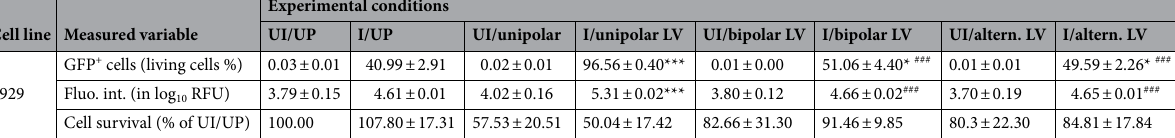
Table 2. Comparison of GFP gene expression and survival of L929 cells after adenovirus infection and delivery of various LV pulse types. L929 cells were infected (MOI = 10 4 vp/cell) and subjected to ten LV pulses either unipolar, bipolar, or with alternate polarities, respectively. GFP + cells (in % of living cells), median of fluorescence intensity (in log 10 RFU) and cell survival (in % of UI/UP cells) were scored by flow cytometry analysis 24 h ± 30 min after the treatment. UI uninfected, I infected, UP unpulsed, LV application of low voltage pulses, fluo. int. fluorescence intensity, altern. alternate. Data are presented as means ± SD (n = 3). Statistical significances: * p < 0.05 and *** p < 0.001 stand for comparisons of GFP + cells and fluorescence intensity versus I/UP condition; ### p < 0.001 for the same comparisons versus I/unipolar LV condition (one-way ANOVA with Bonferroni’s post-test).